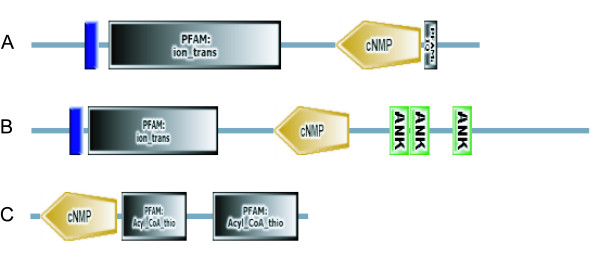
Domain structures of representative CNB domain containing proteins in plants. Scaled images were generated using SMART [60, 62] A) atCNGC2 showing the ion channel, CNB domain and IQ (Calmodulin binding) domain. B) AKT1 showing the ion channel, CNB domain and Ankyrin repeats (ANK). C) atCNTE1 showing the CNB domain and the Acyl-CoA thioesterase domain.